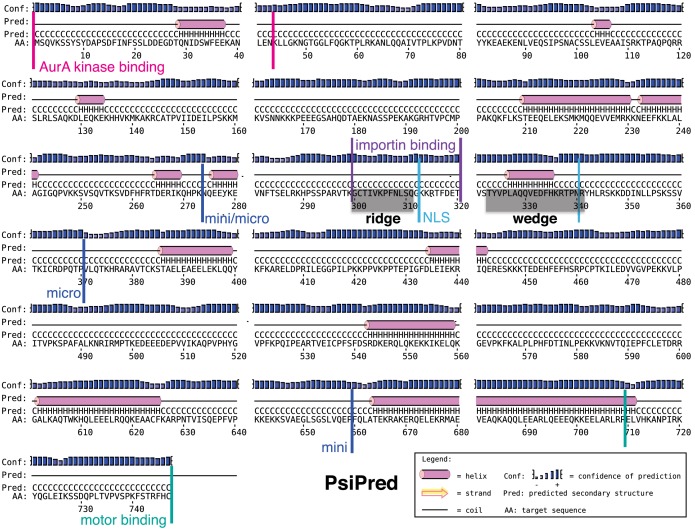
The sequence of human TPX2.Predicted secondary structure for TPX2 obtained using PSIPRED (http://bioinf.cs.ucl.ac.uk/psipred/). α-helices are colored in magenta and beta sheets in yellow. The starting and ending residues for the mGFP-TPX2mini and mGFP-TPX2micro constructs are indicated. The binding sites for Aurora A kinase and importin, and its nuclear localization signal (NLS) sequence are marked. The modeled regions for the ridge and the wedge of TPX2 are highlighted in grey.